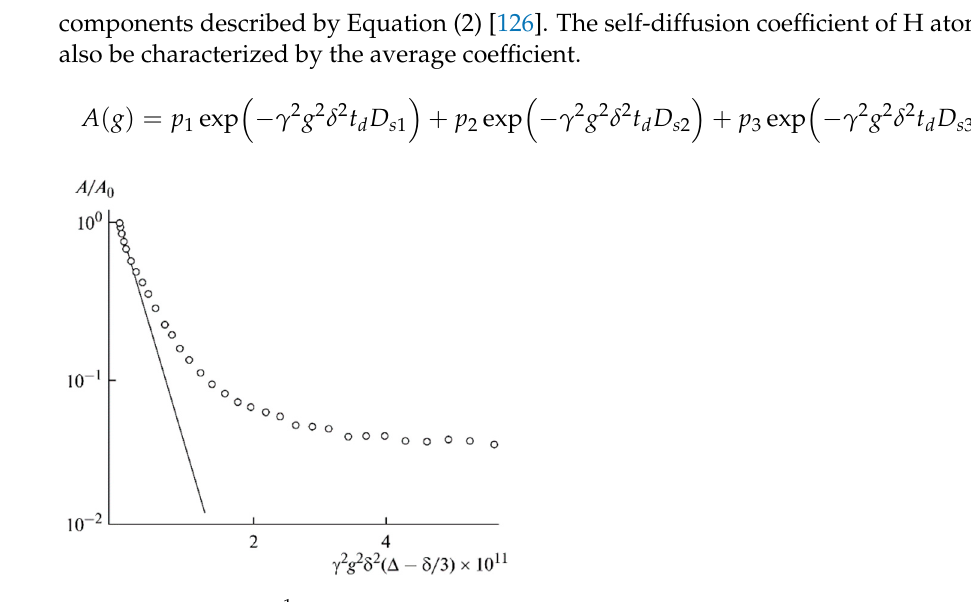
Figure 10. Dependences of the 7 Li spin-echo signal amplitudes on the square of magnetic field gra-